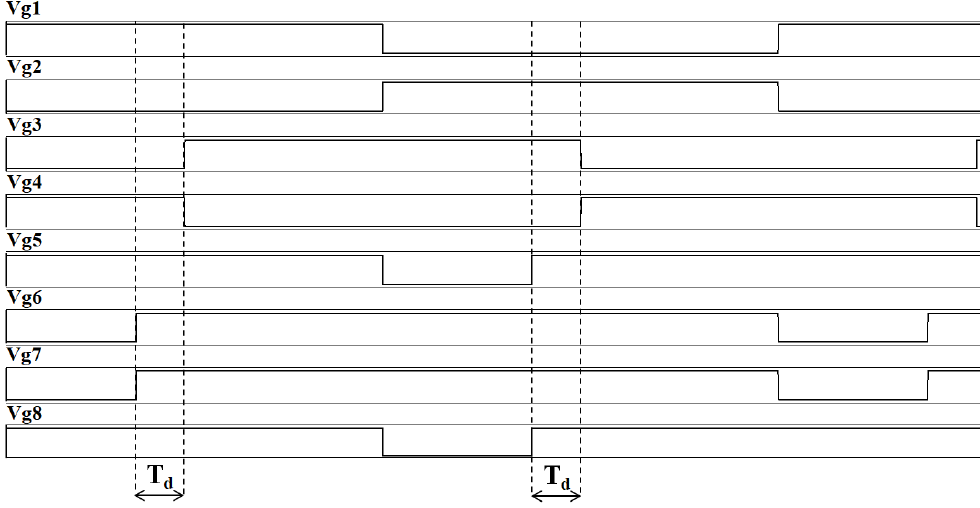
Figure 8. Gate signals in modified PSM.